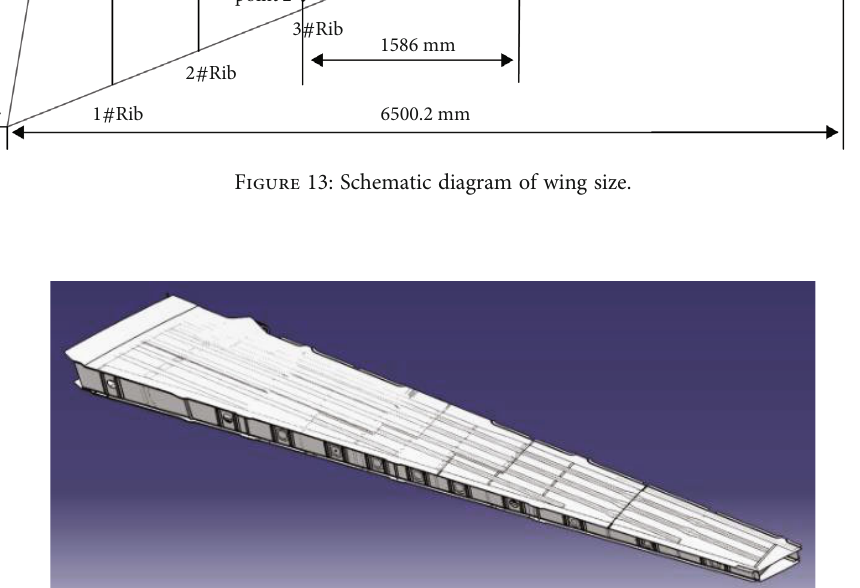
Figure 14: Three-dimensional digital model structure diagram of wing.